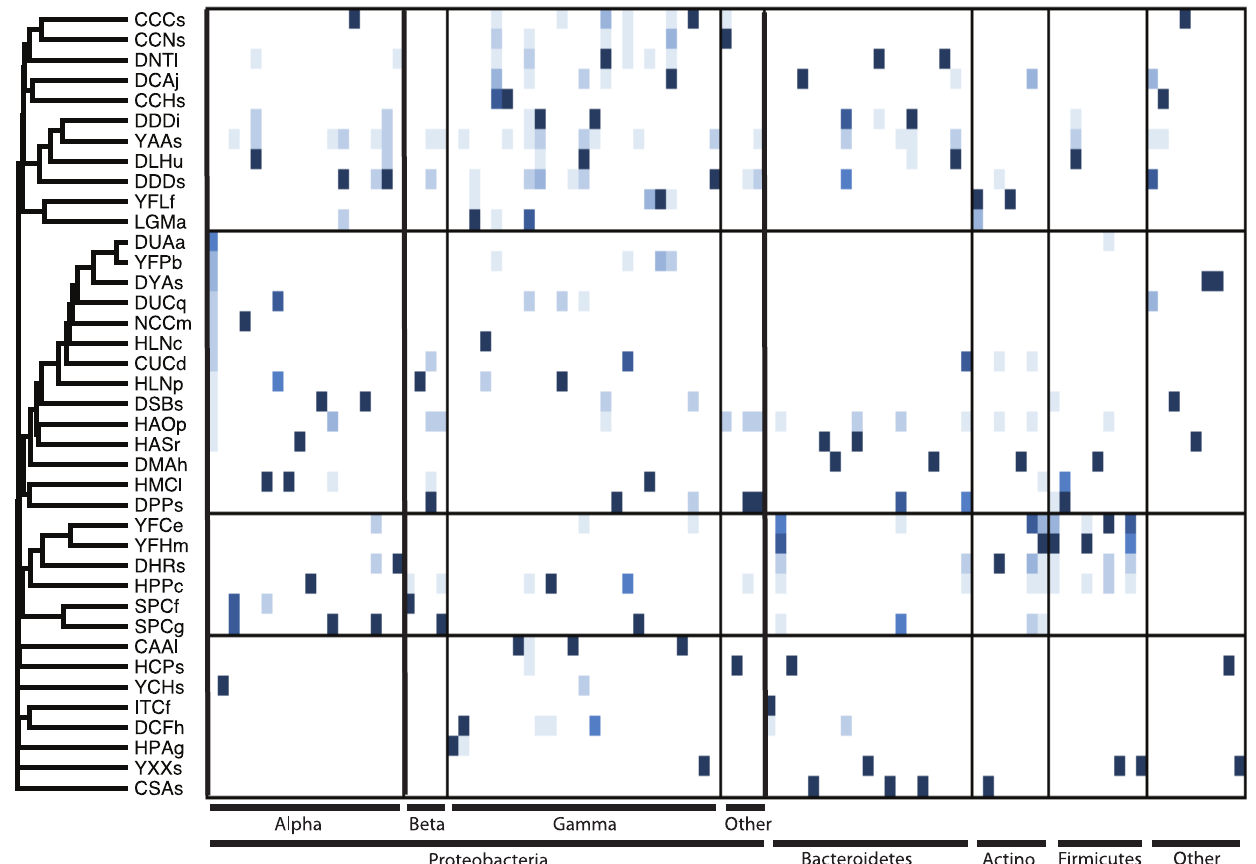
individual insects harbored 7.5 unique bacterial phylotypes, with a range of 1 phylotype per insect to 20 phylotypes per insect (500 sequences analyzed per individual insect specimen). Individual